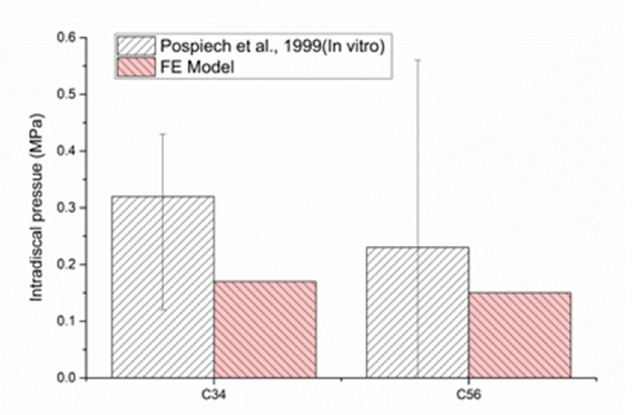
Figure 7. Intervertebral disc stress on segments C3-C4 and C5-C6 under flexion/extension moment of 0.5 Nm and pre-compression load of 10 N (data from